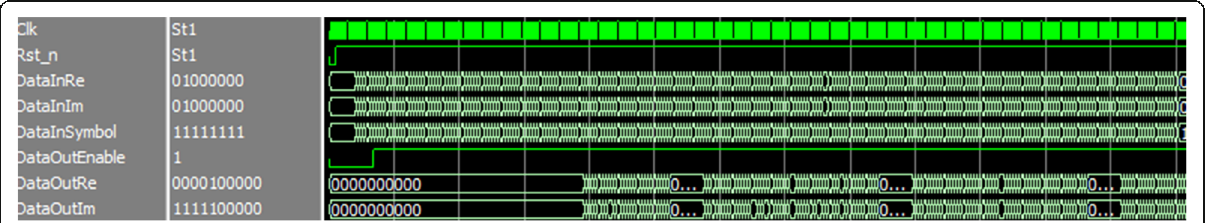
Fig. 10 The simulation results of channel equilibrium. The simulation results of channel equilibrium. Frequency-domain equilibrium is performed to offset the effects of channels on the received signals. And the MMSE equilibrium algorithm is applied as the frequency-domain